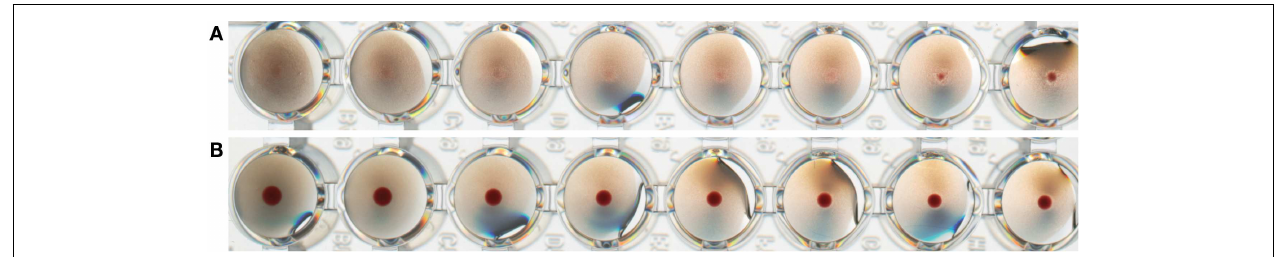
to agglutinate turkey red blood cells (A) , while monomeric HA bound to BLPs displays no hemagglutination property (B) .This suggests that trimeric HA bound to BLPs is properly folded and in biologically active conformation.